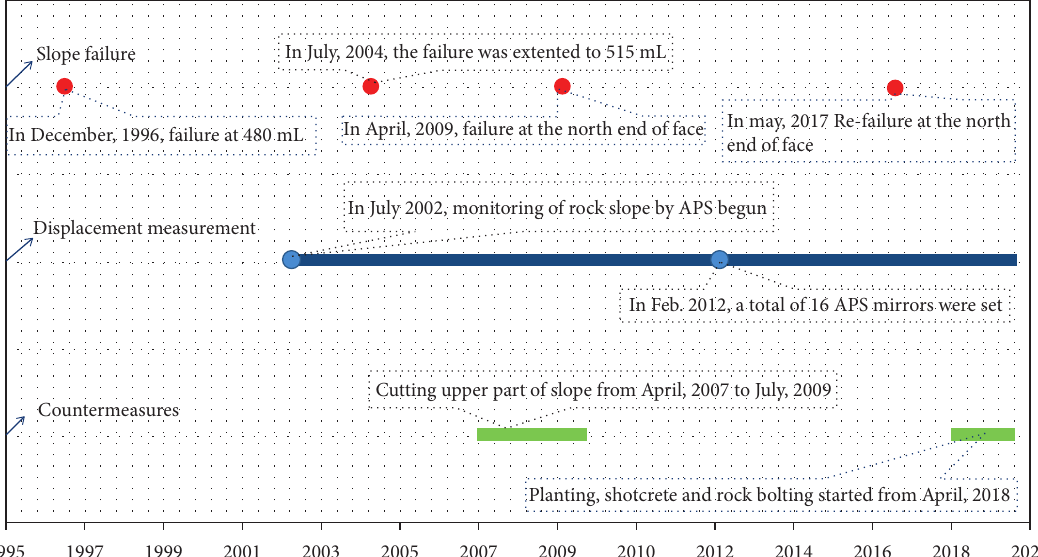
Figure 3: An illustration of events that have occurred at the quarry.